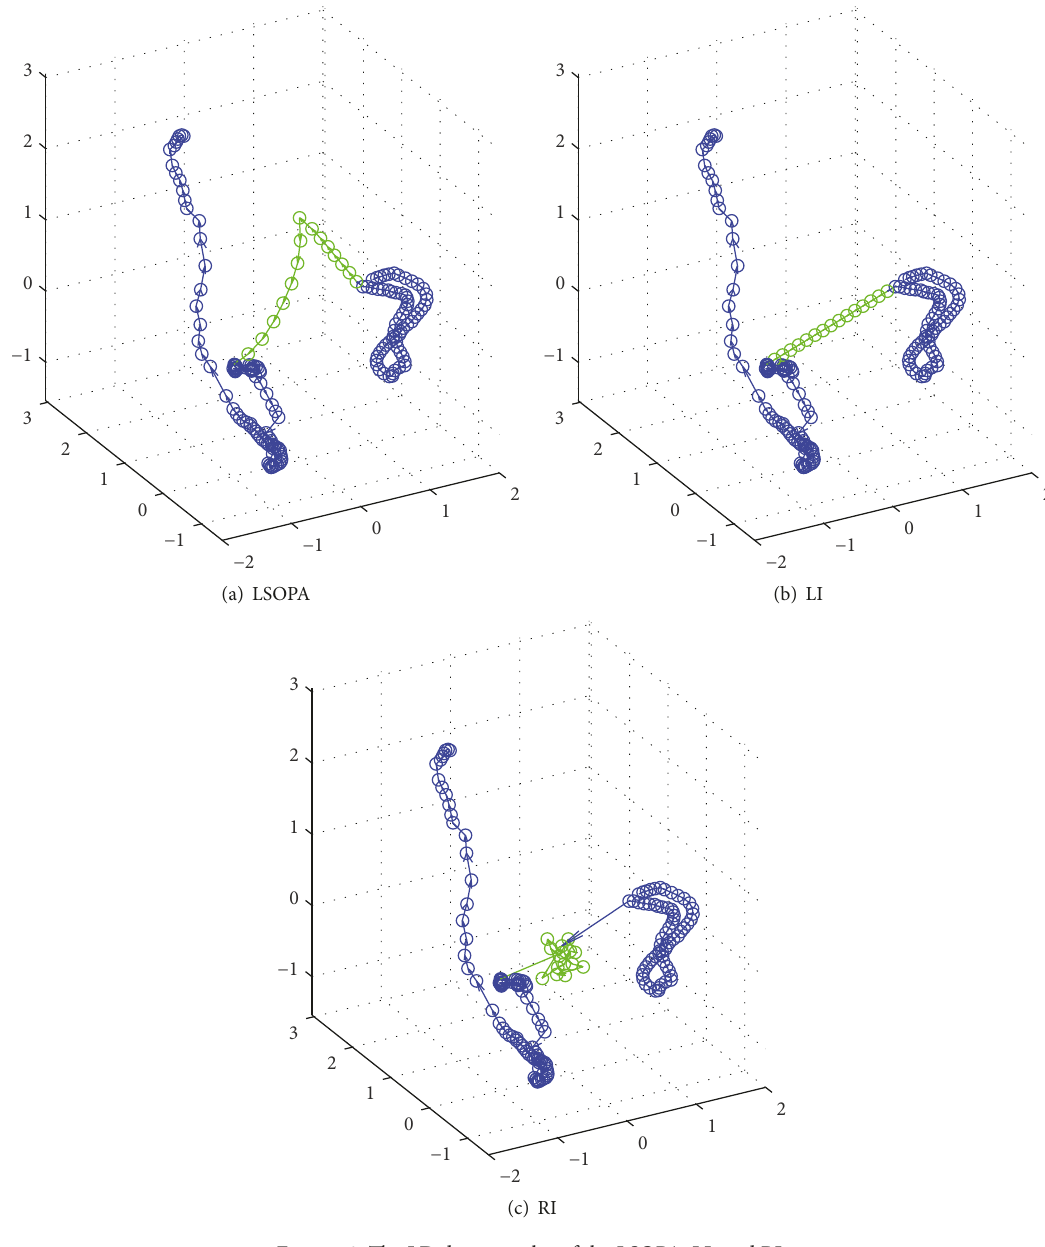
Figure 3: The LD data samples of the LSOPA, LI, and